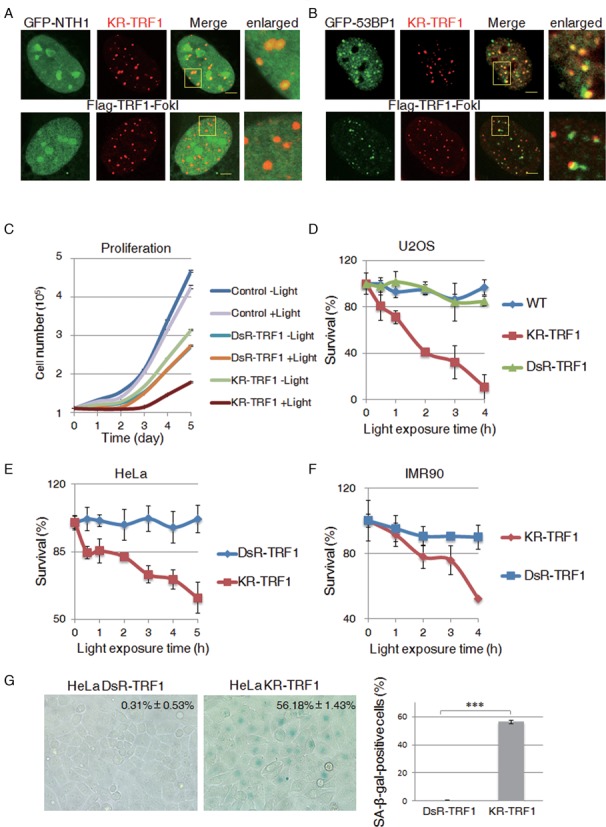
Oxidative DNA damage at telomeres leads to cellular senescence. (A) NTH1 is recruited to sites of KR-TRF1 induced damage but not to Flag-TRF1-FokI induced damage. KR-TRF1 expressing U2OS cells were light activated for 20 min and then fixed immediately for imaging. For Flag-TRF1-fokI analysis, U2OS cells were fixed 24 h after transfection with Flag-TRF1-FokI. Scale bar equals 5 μm. (B) The recruitment of 53BP1 to damaged telomere sites induced by KR-TRF1 and Flag-TRF1-fokI, respectively. (C) Cell proliferation of U2OS cells expressing the indicated proteins with light exposure for 2 h at indicated recovery time. (D) Clonogenic survival of U2OS cells expressing KR-TRF1, DsR-TRF1 and NLS-KR after the indicated dose of light treatment. (E) Clonogenic survival of HeLa cells expressing DsR-TRF1 and KR-TRF1 after the indicated dose of light treatment. (F) MTT assay of IMR90 cells expressing KR-TRF1, DsR-TRF1 and NLS-KR after the indicated dose of light treatment. (G) SA-β-gal staining of DsR-TRF1 and KR-TRF1 stable-expressing HeLa cells. Percentages of SA-β-gal-positive cells (n = 100) are obtained from three independent experiments. Error bars are derived from SDs in three independent experiments from (a–e).